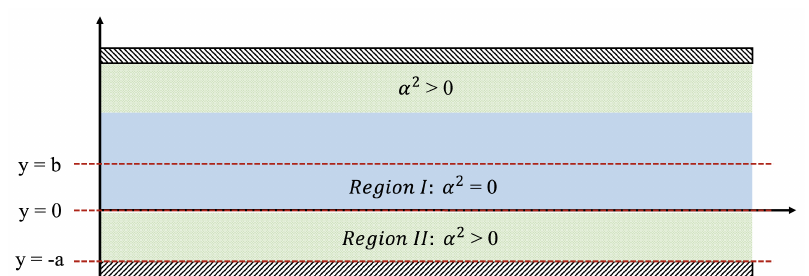
Figure 2. Depicting the physical setup for the Brinkman equations. There are two regions of interest, namely where α 2 = 0 and α 2 > 0.